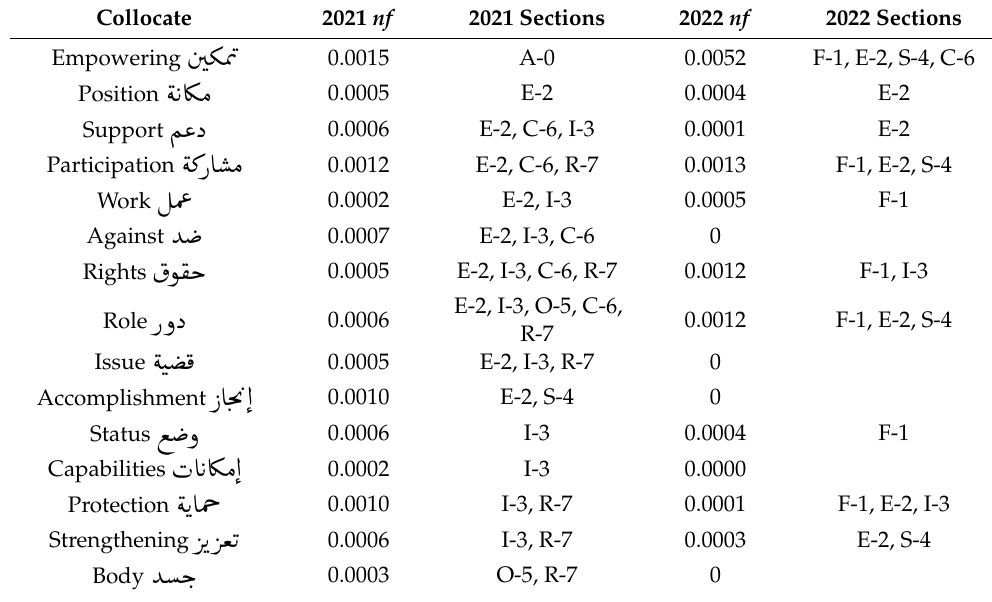
Table 10. Absolute frequencies ( f ) of the co-occurrences for 2021 and 2022.